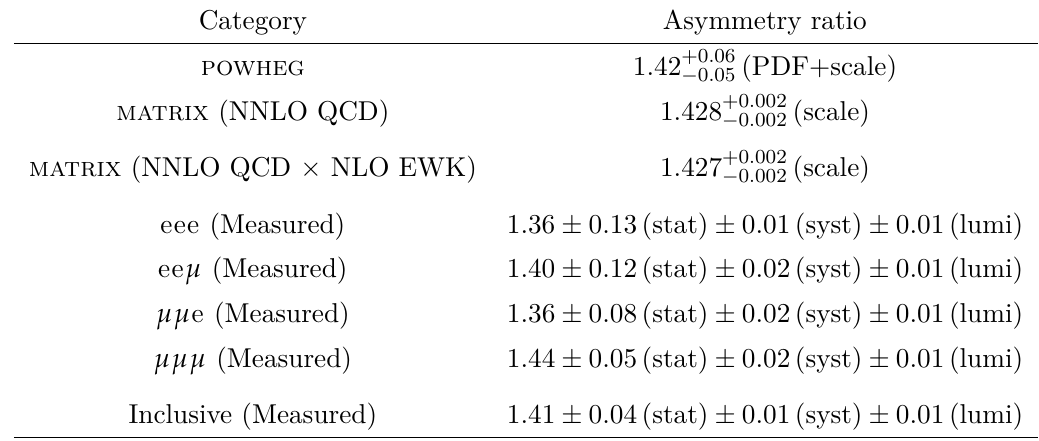
Table 10 . Measured ratios of fiducial cross sections and their corresponding uncertainties for each of the individual flavour categories, as well as for their combination. The predictions from both matrix (at NNLO QCD and NNLO QCD × NLO EWK) and powheg (at NLO QCD) are also